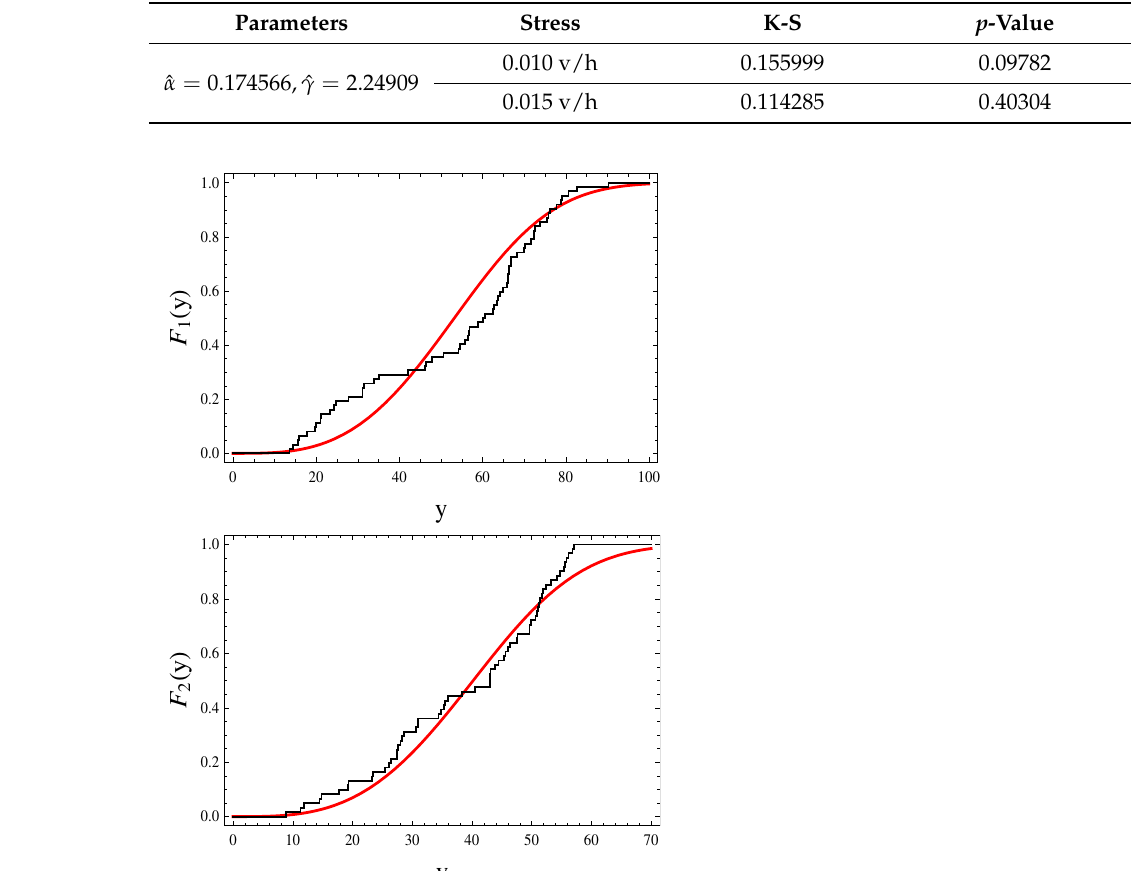
Table 4. MLEs of the parameters, K-S statistic, and p -value.